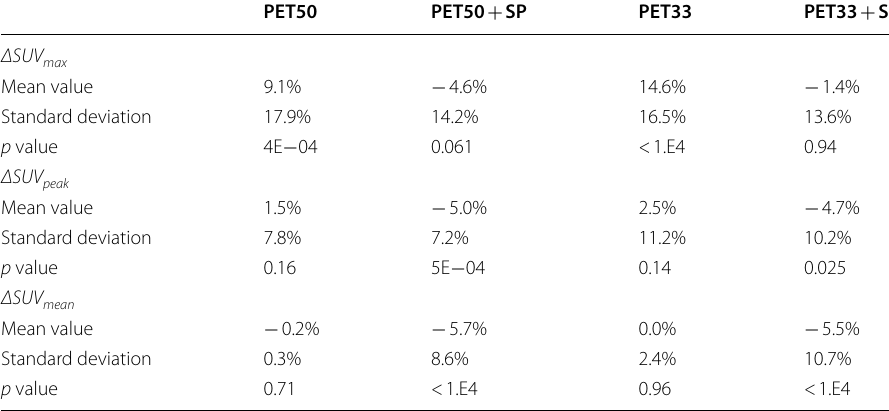
Table 3 Mean SUV indexes variation in comparison to PET100, considering the visible spheres pooled from the 3